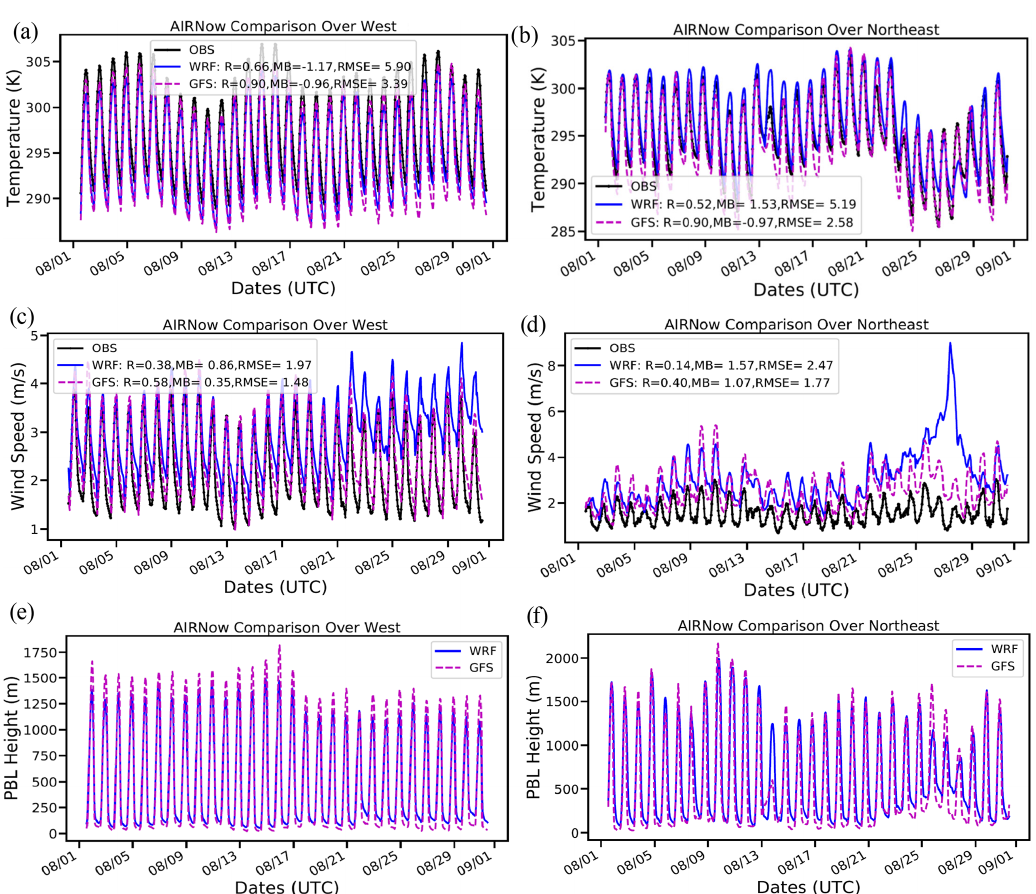
Figure 3. The WRF and GFS time series comparison for AIRNow stations over the western and northeastern US for 2m temperature (a, b) , 10m wind speed (c, d) and PBL height (e, f)